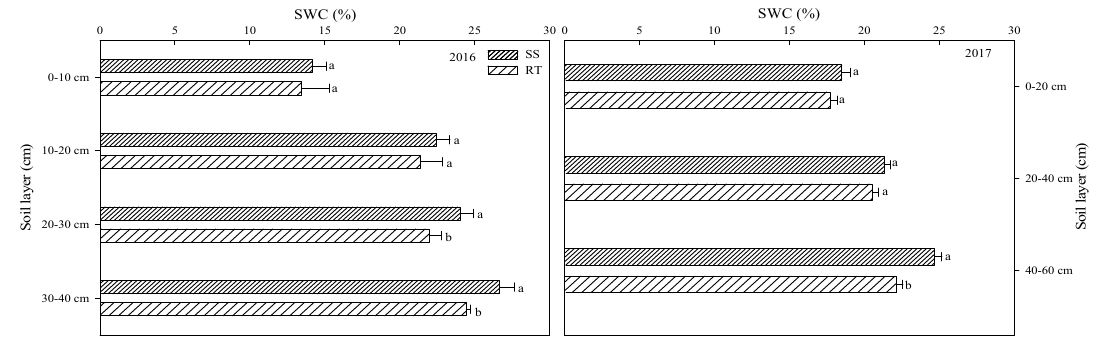
Figure 6. SWC in the 0–60 cm soil layer under different tillage practices at the big flare stage. Different small letters under the same soil layer indicate significant differences between tillage practices.